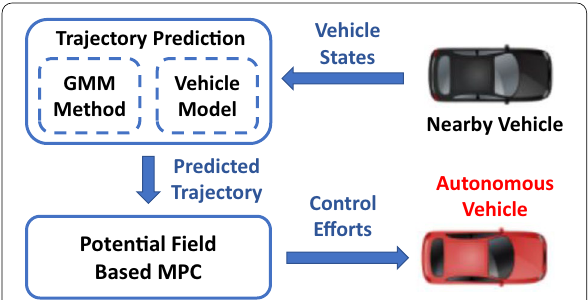
Figure 2 Structure of the lane-exchanging driving